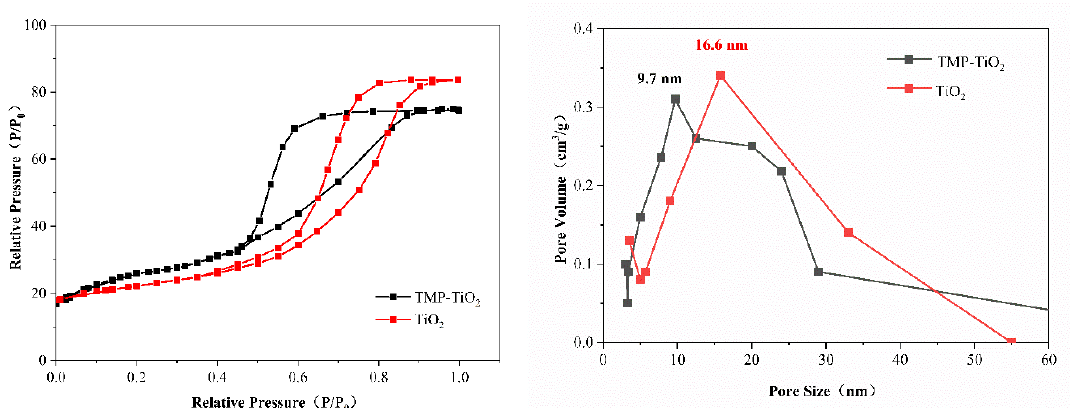
Figure 5. N 2 adsorption–desorption isotherm pore and the size distribution curves of unmodified TiO 2 and TMP-TiO 2 nanocomposites.